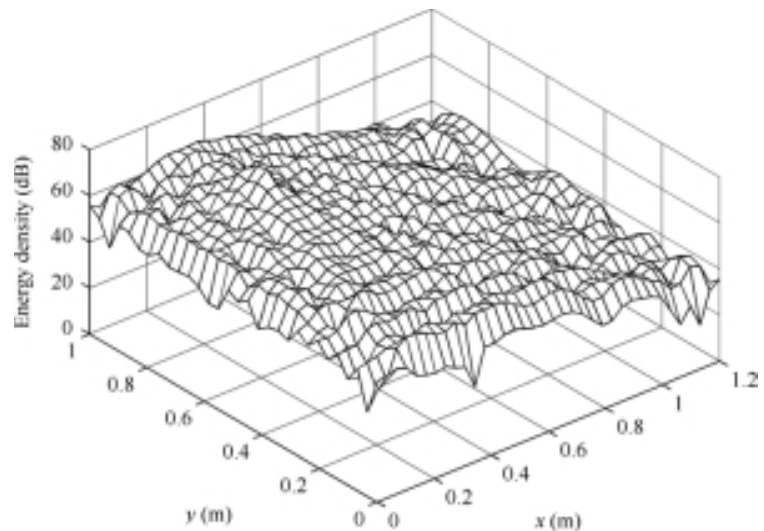
Fig. 23. The classical energy density distribution of the orthotropic plate with L x = 1 . 2 m and L y = 1 m when x o = 0 . 3 m, y o = 0 . 7 m, f = 5 kHz and η = 0 . 1 . The reference energy density is 1 × 10 − 12 J/m 2 .